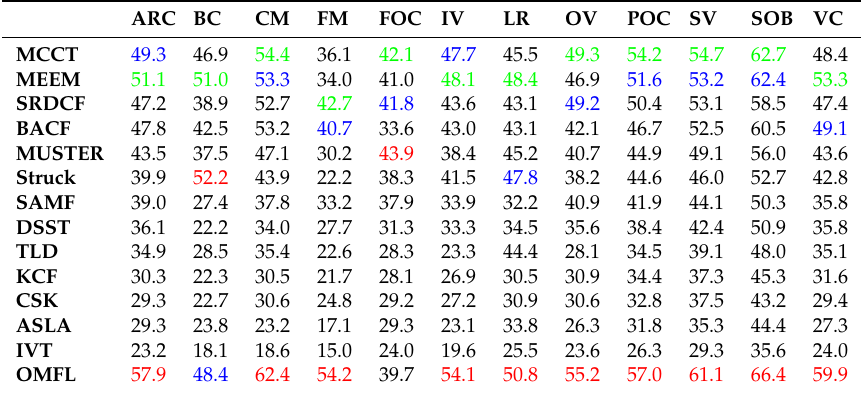
Table 2. Scores of precision plots ( ξ = 20 pixels). Red, blue and green fonts indicate the best, second best and third best performances among all trackers.